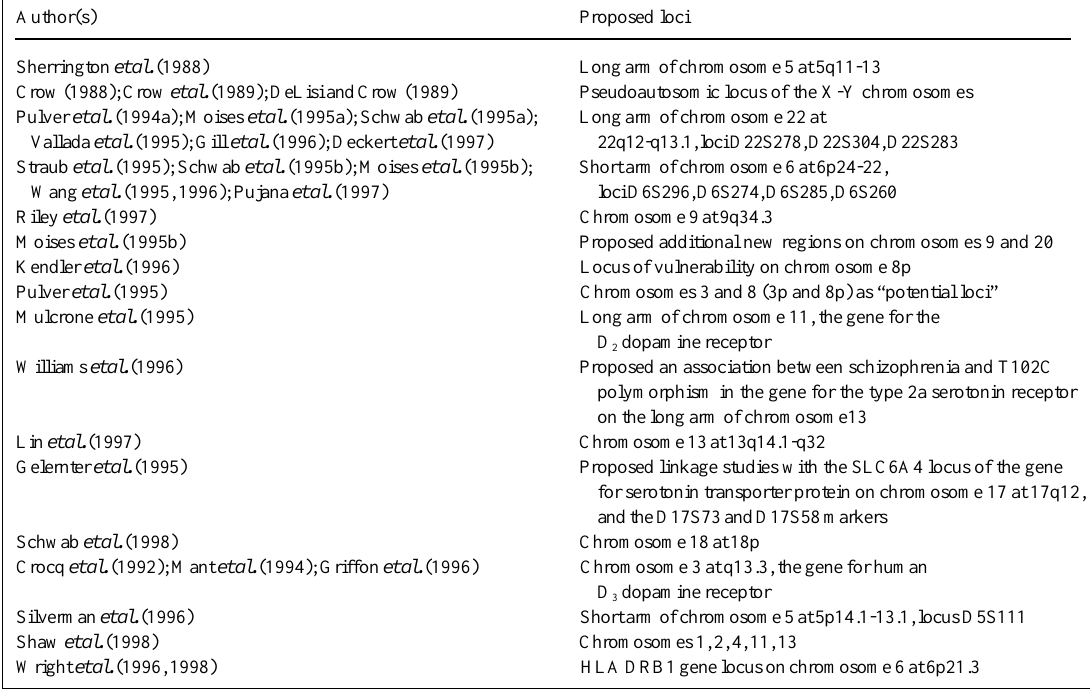
Table I - Proposes and localization of genes modulating the predisposition to